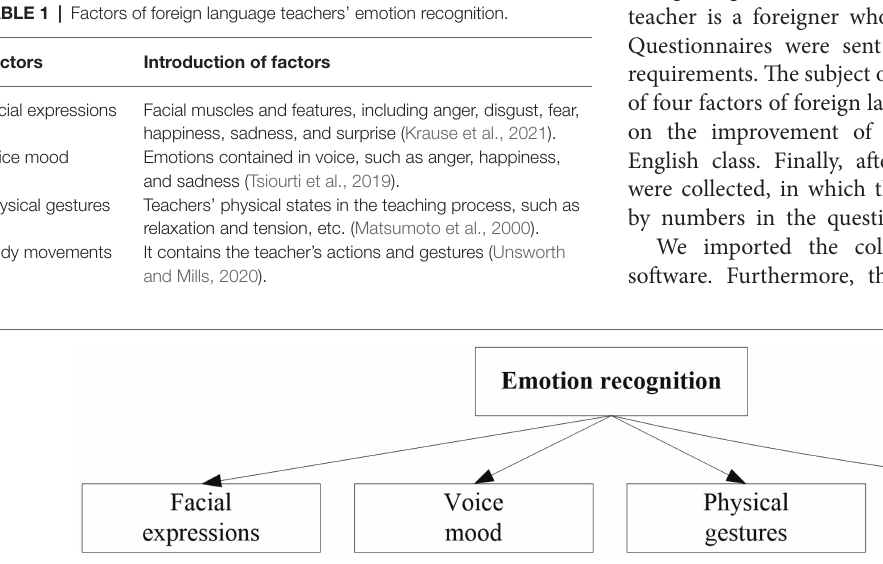
FIGURE 1 | Emotion recognition